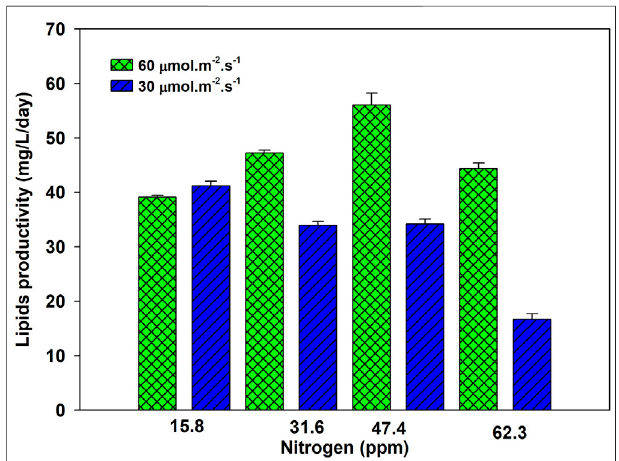
FIGURE 2 | Lipid productivity of Parachlorella kessleri HY-6 at different nitrogen concentrations under 30 and 60 μ mol m − 2 s − 1 under 2% CO 2